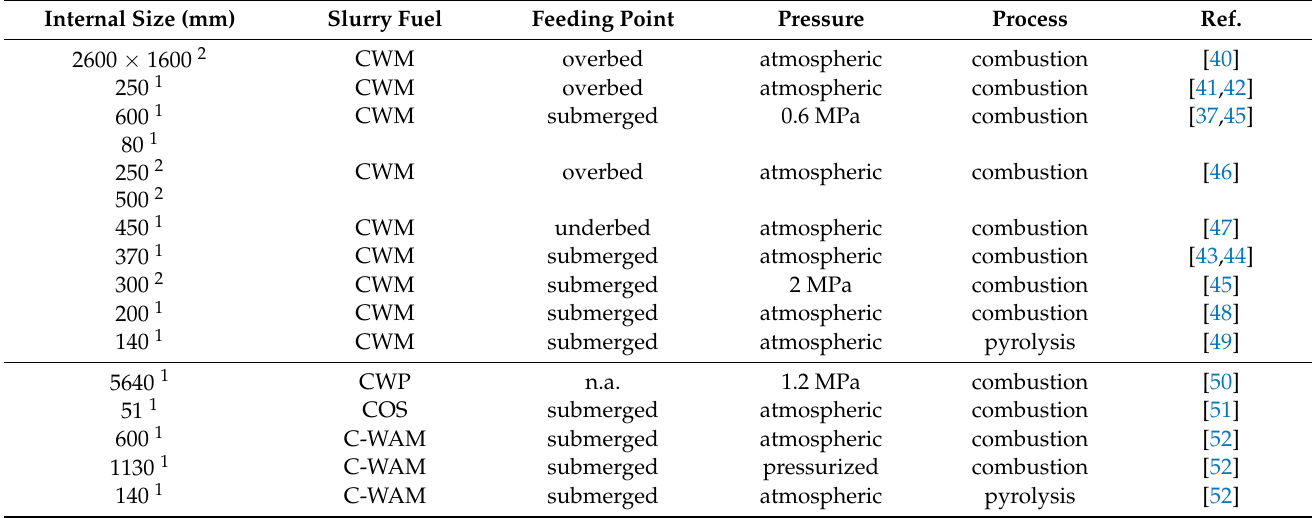
Table 1. Investigations on coal-based mixtures in fluidized